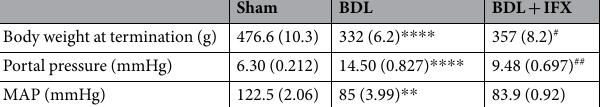
Table 1. Physical and haemodynamic measurements. Data are shown as mean (standard error). ** p < 0.01, **** p < 0.0001 compared to Sham. # p < 0.05, ## p < 0.01 compared to BDL. (Sham n = 10; BDL n = 10; BDL + IFX n = 7).